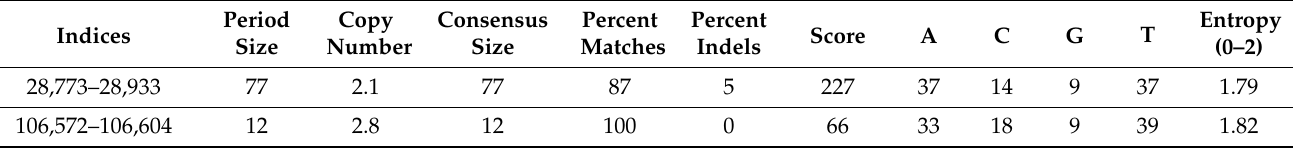
Table 3. Tandem repeats detected in the Trebouxiophyceae sp. DW1 chloroplast genome using the Tandem Repeats Finder.